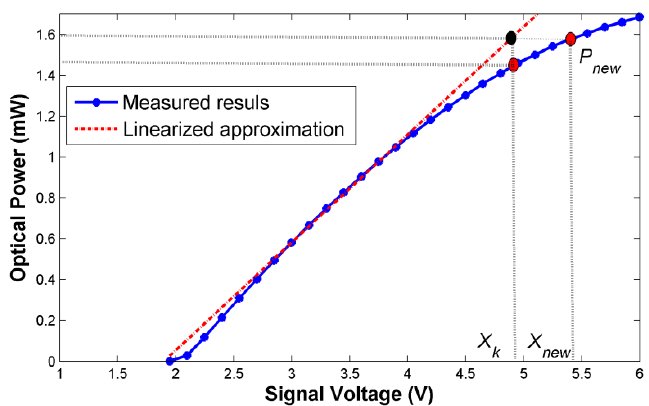
Figure 4. The principle of the pre ‐ distorter.